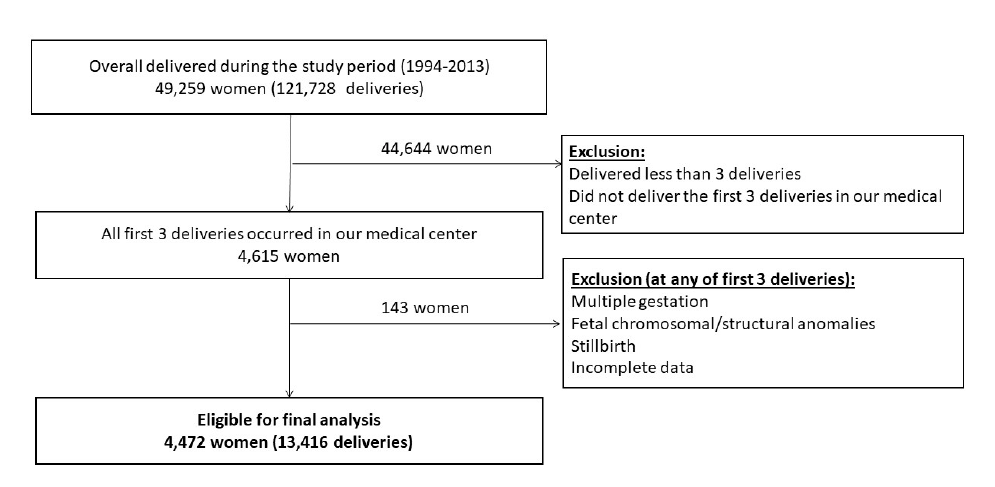
Figure 1. Selection of the study cohort.